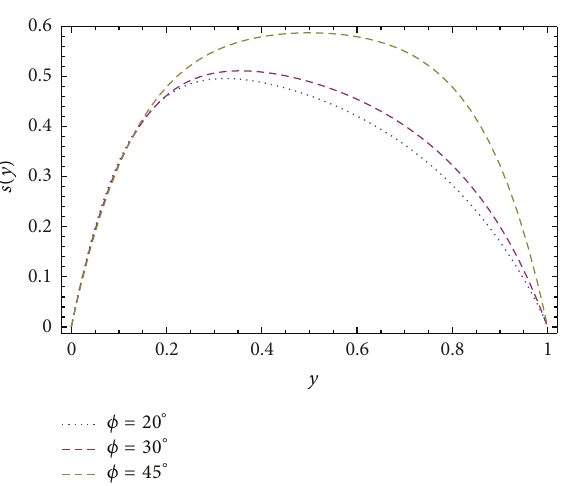
Figure 10: Profile of the nondimensional velocity 𝑠(𝑦) for different ̃𝛽 = 0.3 , 𝑃 ,𝑥 = −2.0 , and 𝜙 = 45 ∘ . values of 𝑃 ,𝑧 , keeping